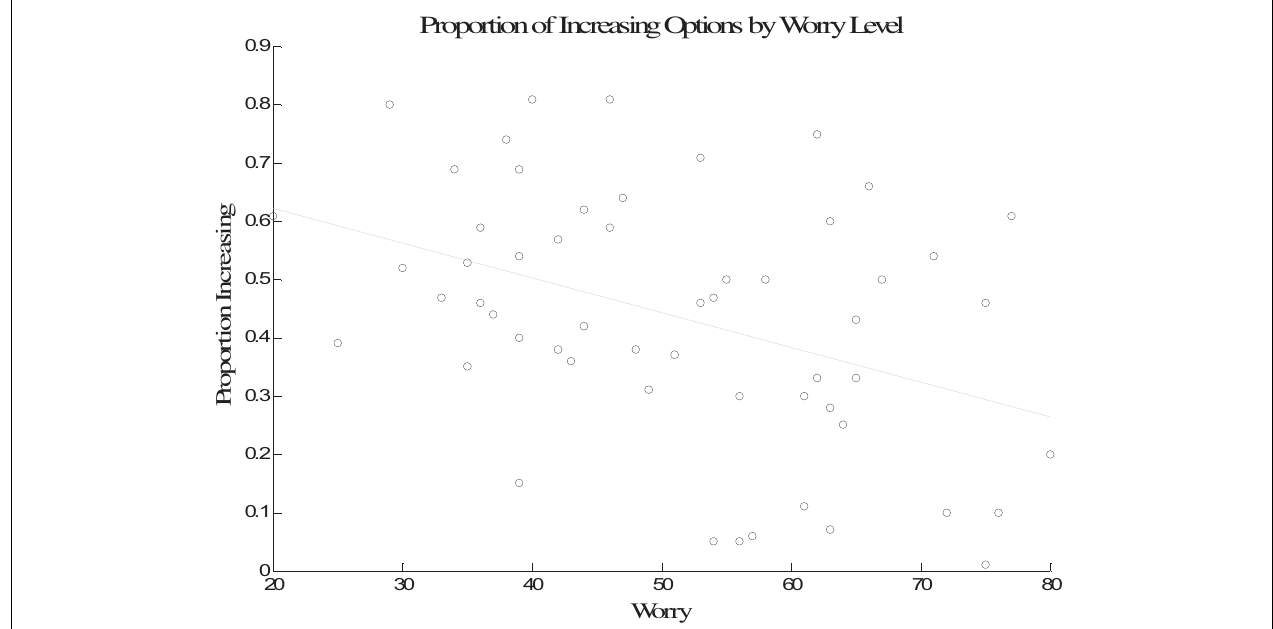
FIGURE 2 | Performance (proportion in increasing option selections) plotted as a function of worry.